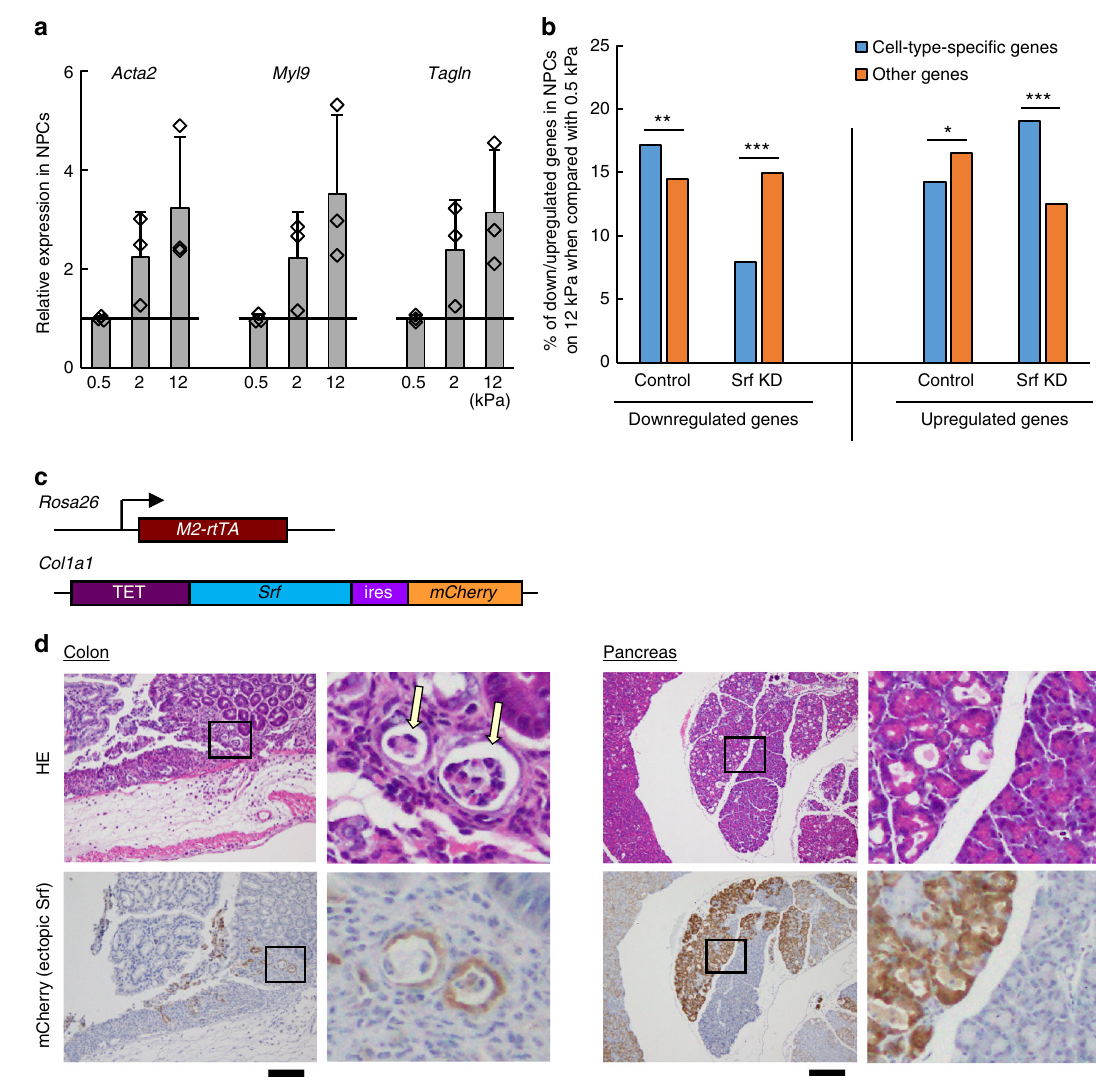
Fig. 6 Srf misactivation causes various diseases. a Srf activity is regulated by an exogenous cue, extracellular matrix stiffness. The expressions of Srf target genes in NPCs cultured on matrices of various stiffness relative to the value of each gene on the softest matrix (0.5 kPa). Values are means ± SD of the relative expression levels normalized to Gapdh expression ( n = 3). Dots indicate individual data points. b Cell-type-speci fi c genes are downregulated by Srf with stiffness. Percentages of genes differentially regulated in NPCs among cell-type-speci fi c genes and other genes between 0.5 and 12 kPa matrices. Two-sided Fisher ’ s exact test (*** P < 0.0005, ** P < 0.005, * P < 0.05). c Structure of transgenes in KH2-Srf mice. d Srf misactivation causes diseases. Immunohistological observations of chimeric mice that were treated with Dox for 7 days. Upper images are representative images of hematoxylin/eosin staining (HE) and lower images are roughly corresponding view fi elds of immunohistochemistry sections for Srf ectopic expression (mCherry) in colon and pancreas in a chimeric mouse overexpressing Srf . Right panels of each tissue are magni fi ed views of the areas indicated by the squares in the respective left panels. Arrows indicate sites exhibiting crypt abscess. Bars, 200 µ